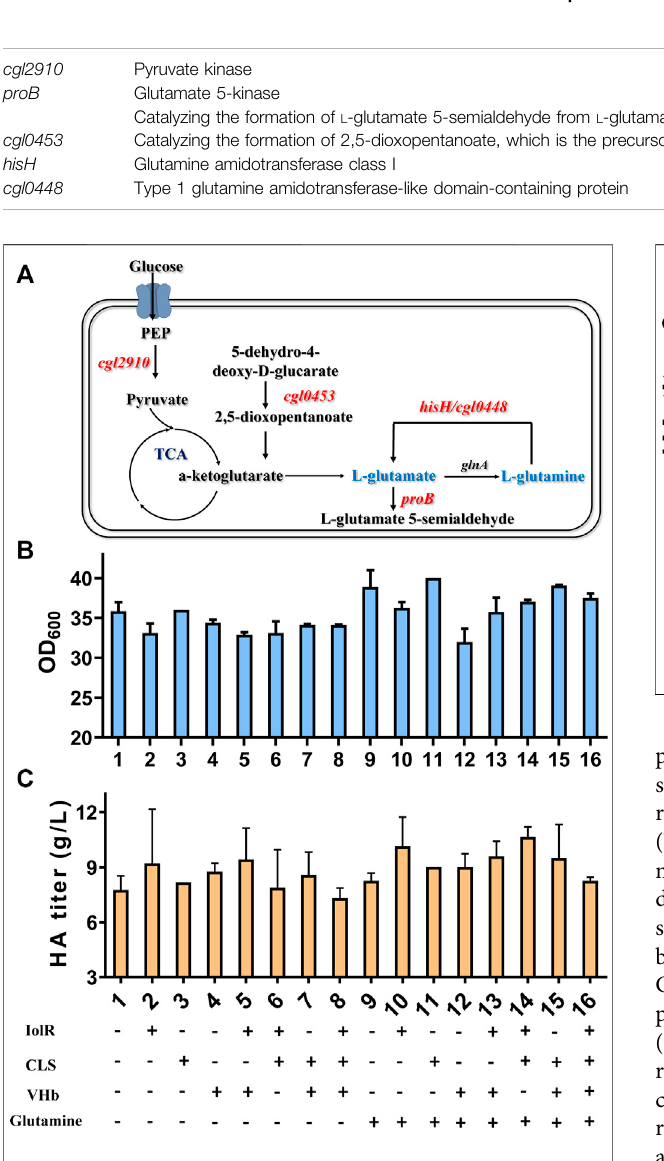
FIGURE 6 | Glutamine metabolic pathway and effects of combined four strategies on cell growth and HA synthesis. (A) The key enzymes identi fi ed by transcriptome analysis are involved in glutamate or glutamine synthesis. (B) OD 600 results of eight engineered strains under 16 different conditions. (C) HA titer of eight engineered strains under 16 different conditions.